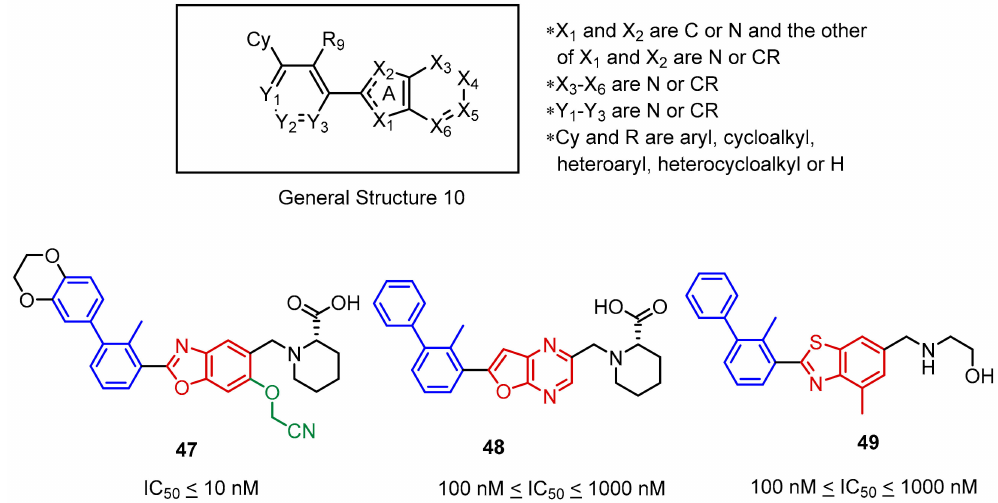
Figure 20. General structure and examples of PD-1 / PD-L1 inhibitors ( 47 – 49 ) reported by Incyte Corporation in the second patent. Aryl ether fragment is shown in green.